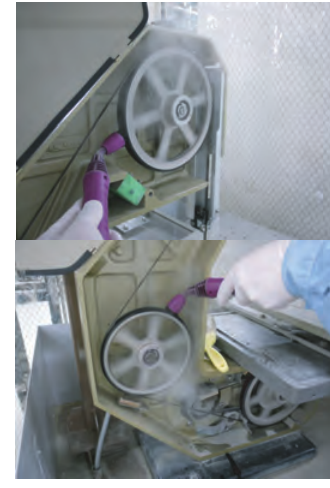
Figure 3. Cleaning run. Band saw and three wheels must first be cleaned with heat-steam followed by an ethanol spray-wash and a Milli-Q rinse.